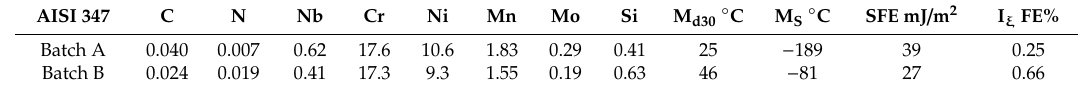
I ξ parameter of the two investigated batches of AISI 347 is given in Table 1. Table 2 summarizes the mechanical properties of the investigated material at ambient temperature (AT) and T = 300 °C as Table 1. Chemical composition in weight % and metastability parameters. well as α ’-martensite content after specimen failure. Table 1. Chemical composition in weight % and metastability parameters.